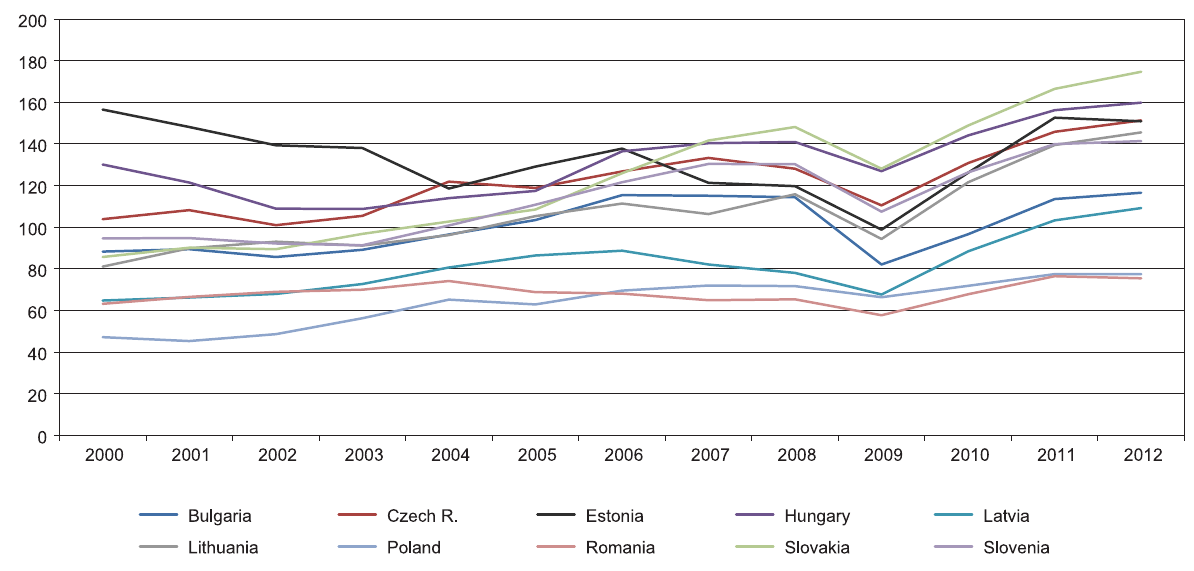
Fig 1. The openness of post-communist countries to the world, the years 2000–2012. Source: calculated by the authors on the basis of the World Integrated Trade Solution data, the World Bank.